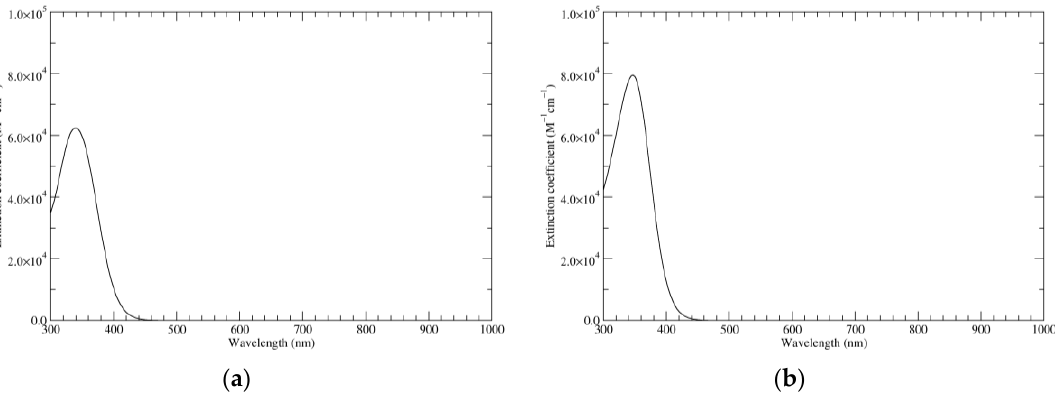
Figure 1. Computed ultraviolet–visible (UV–Vis) spectra of the most significant tautomers/conformers in the reduced state. ( a ) Neutral form in vacuo, a0_b0_c0_d0, S 4 . ( b ) Neutral form in water, a0_b0_c0_d0, S 4 .